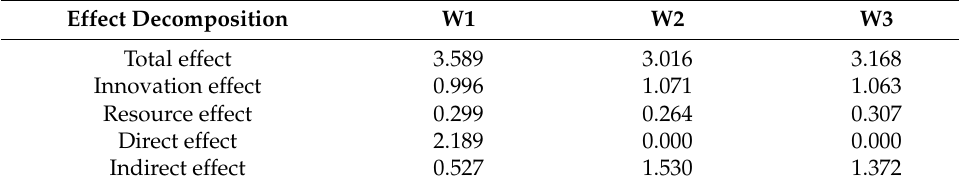
Table 6. According to Equation (9), we calculated the direct effect and the indirect effect, and all effect values are summarized in Table 8. Table 8. The summary of